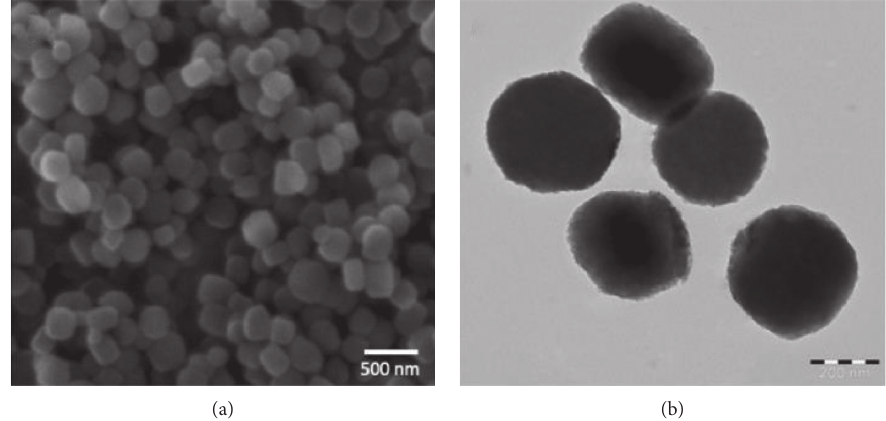
Figure 1: (a) SEM images of fabricated mesoporous silica nanoparticles (bare MSNs). (b) TEM images of prepared mesoporous silica nanoparticles (bare MSNs).